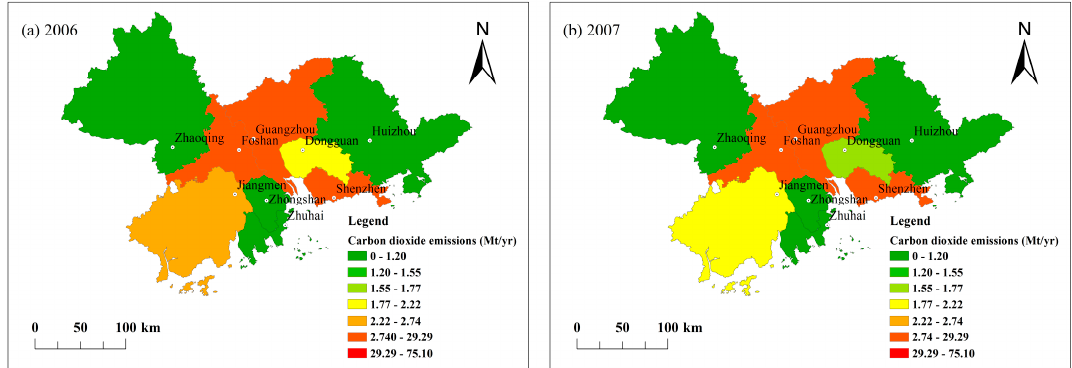
Figure 9. CV and Global Moran’s I of the CO 2 emission in the Pearl River Delta, 2006–2016.